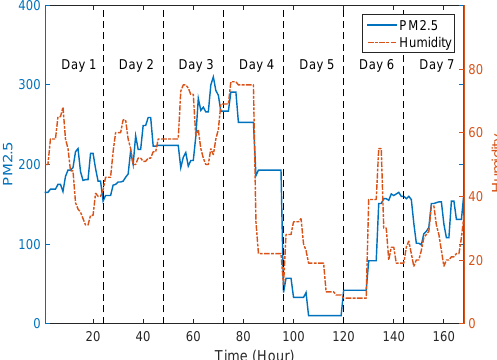
Figure 14. Variation tendency of PM2.5 and air humidity in monitoring station S 9 during the time period of 21–27 April 2013.